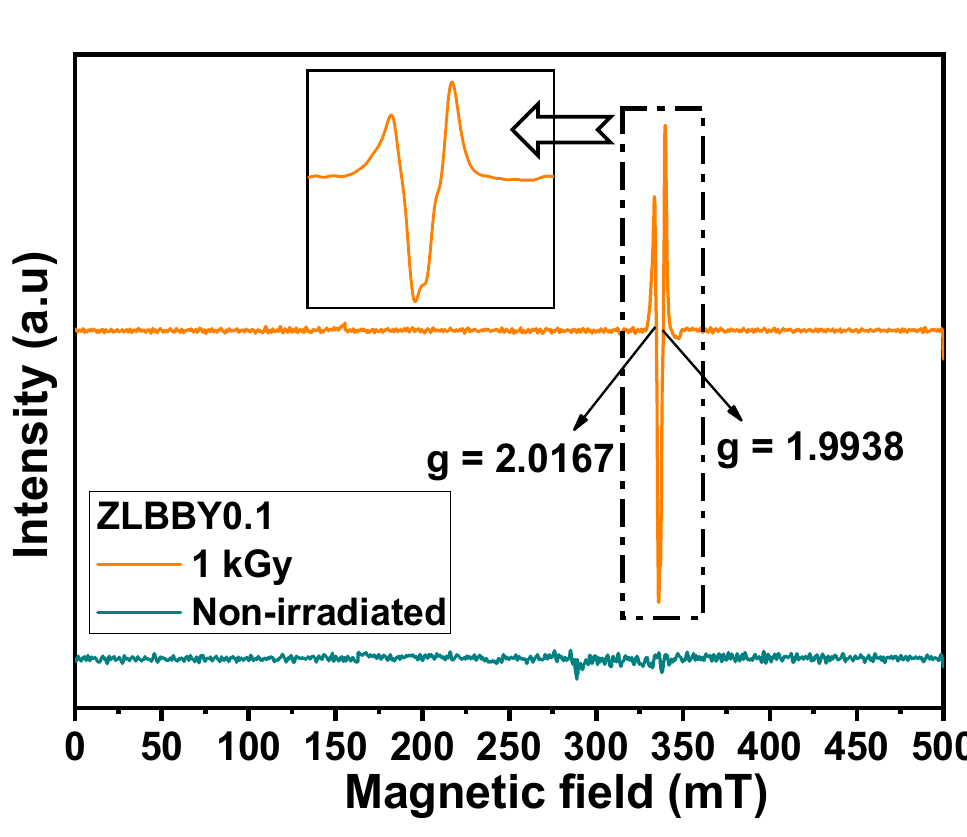
Figure 5. Stacked ESR profile of the non-irradiated and the 1 kGy γ -irradiated ZLBBY0.1 glasses. Here, the notation ‘ · ’ means an unpaired localized electron [17]. The H ◦ appearing in the above equation is observed when irradiation and ESR measurement are performed together at temperatures of ≤ 100 K and at temperatures of ≥ 120 K; the species becomes mobile and vanishes